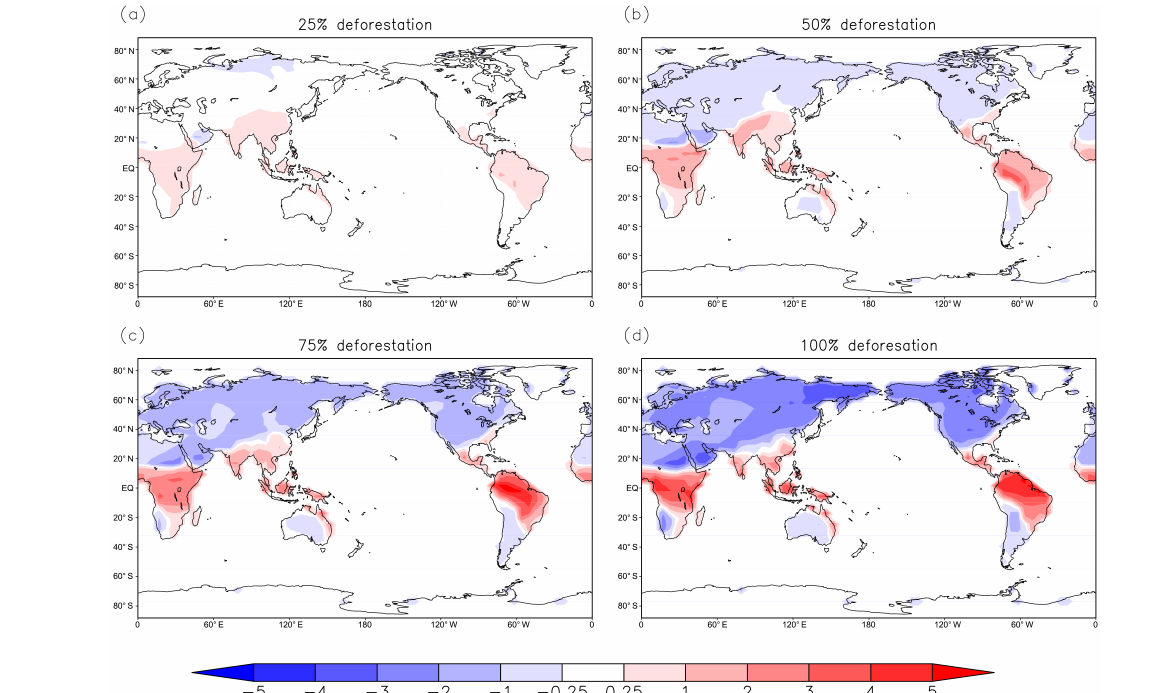
Figure 2. Temperature change for global deforestation experiments with different deforestation fractions at (a) 25%, (b) 50%, (c) 75%, and (d)